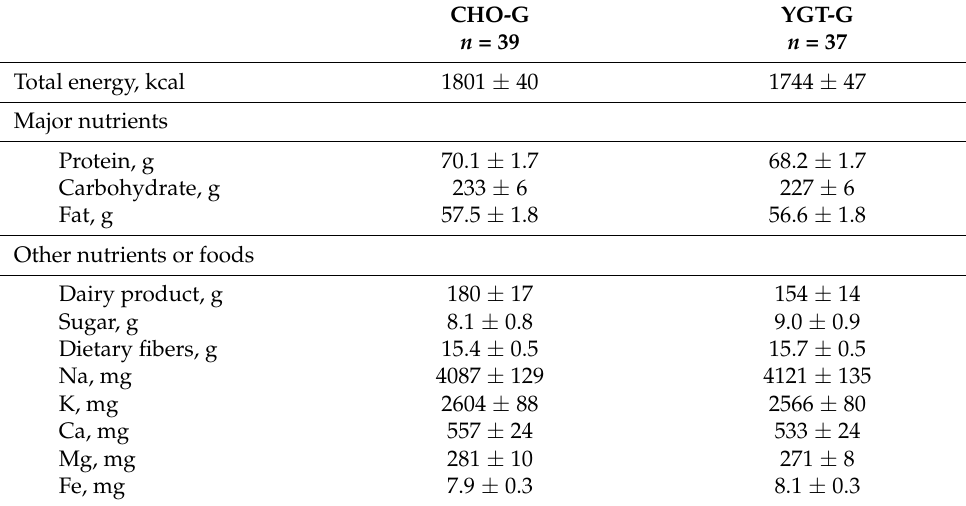
Table 5. The composition of dietary intake per day during the training